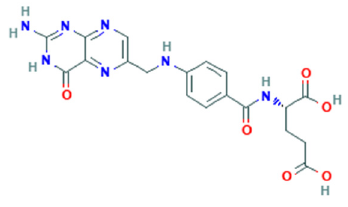
Figure 1. Folic acid structure.